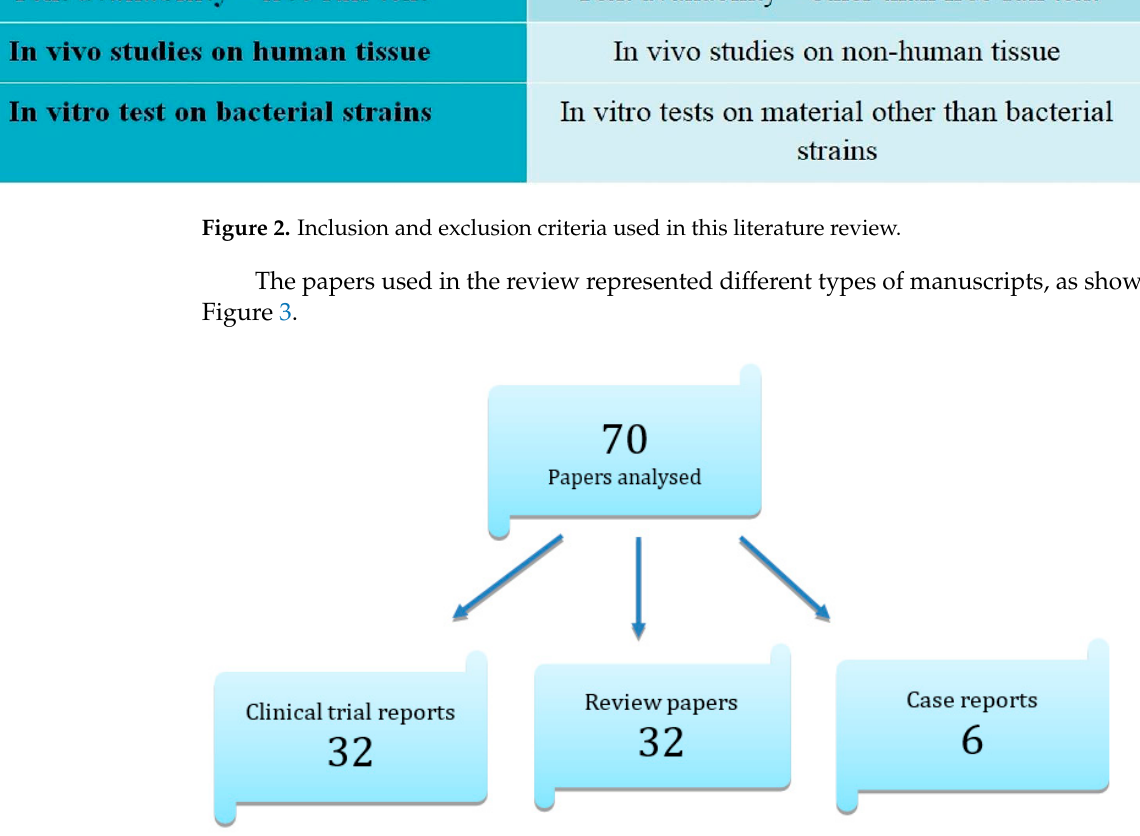
Figure 3. Breakdown of the literature included in the review by manuscript type.